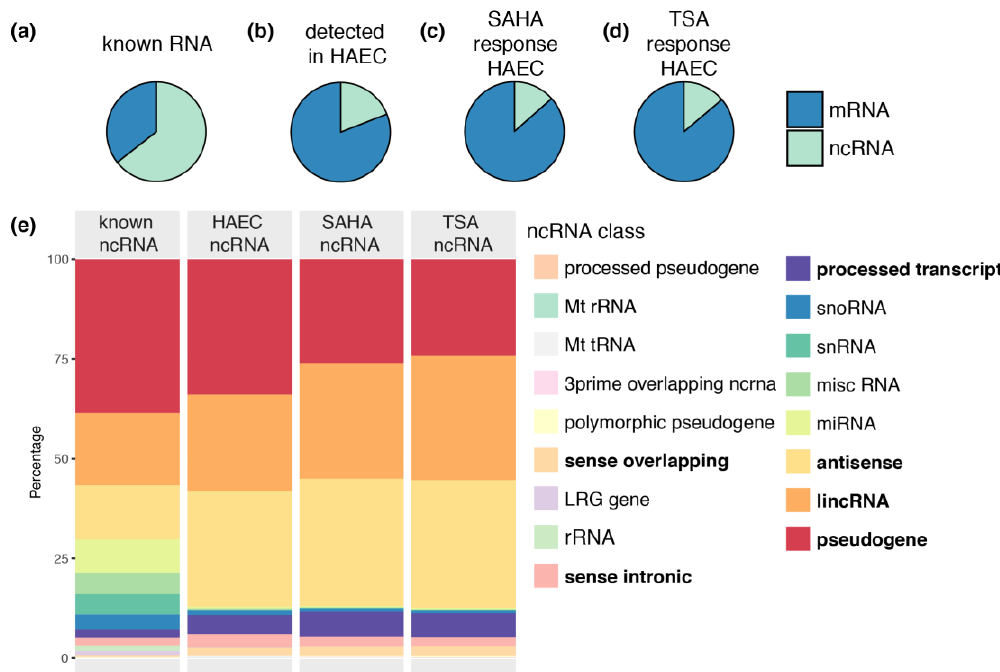
Figure 1. HDAC inhibitors regulate the expression of ncRNAs. Pie charts comparing ( a ) relative number of known mRNA and ncRNA; ( b ) relative number of mRNA and ncRNA genes detected in HAECs by RNA-seq, and relative number of mRNA and ncRNA differentially expressed in HAECs stimulated with HDAC inhibitors ( c ) SAHA and ( d ) TSA (FDR p value < 0.05); ( e ) A stacked bar chart compares percentages of known ncRNA classes, ncRNA classes detected in HAECs by RNA-seq, and the percentage of ncRNA classes differentially expressed by SAHA and TSA in HAECs (FDR p value < 0.05). Abbreviations: Mt rRNA: mitochondrial ribosomal RNA; Mt tRNA: mitochondrial transfer RNA; LRG gene: Locus Reference Genomic gene; rRNA: ribosomal RNA; snoRNA: Small nucleolar RNA; snRNA: small nuclear RNA; misc RNA: Miscellaneous RNA; miRNA: microRNA; lincRNA: long intergenic non-coding RNA.